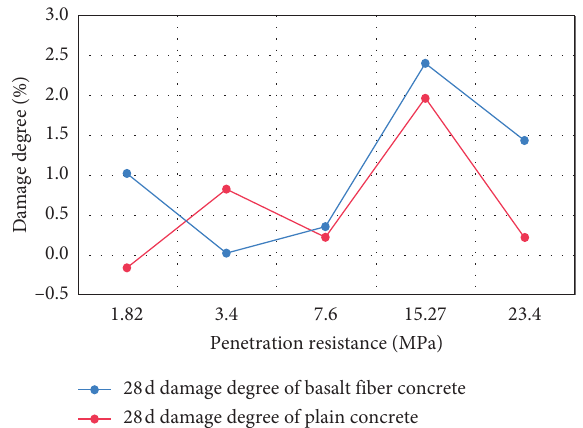
Figure 6: Damage degree of basalt fiber concrete and plain con- crete for 28d.